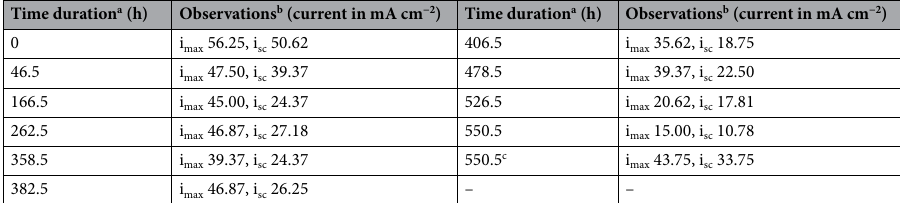
Time duration a